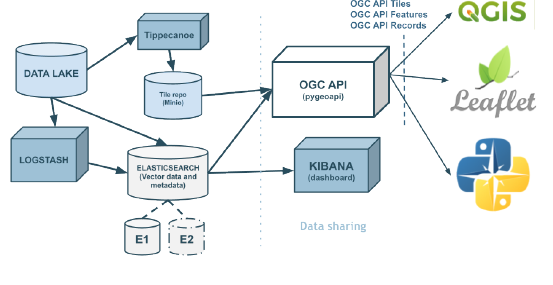
Figure 4. OGC API - Features support in QGIS